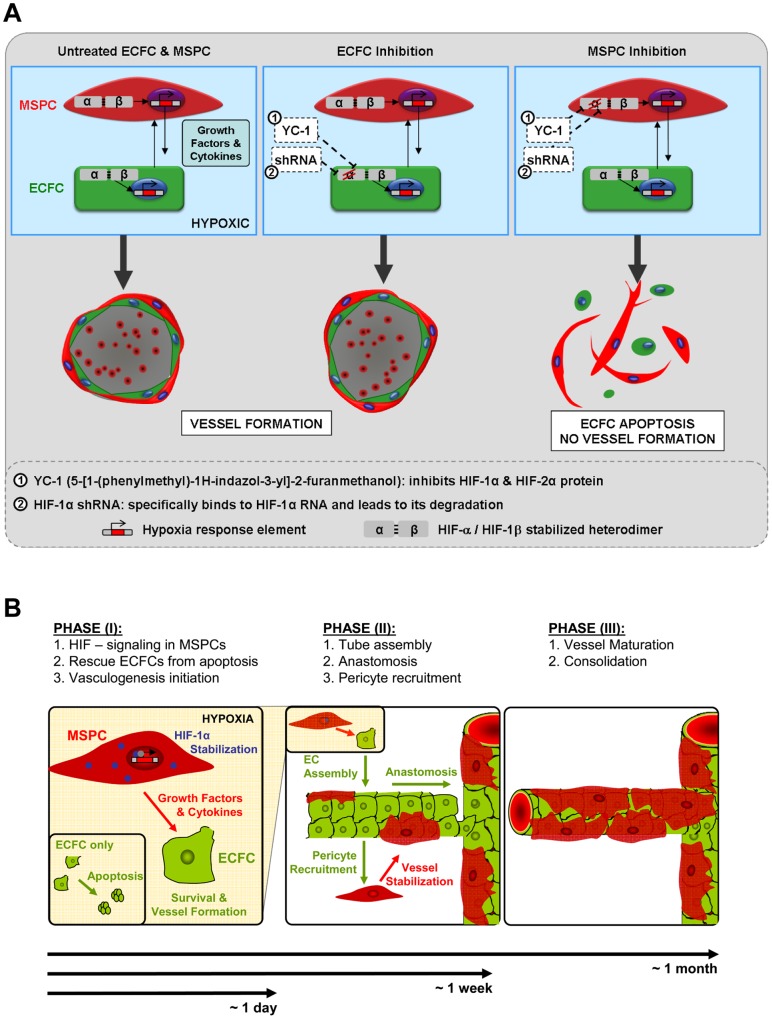
MSPCs are responsible for oxygen sensing and induction of neo-vasculogenesis.(A) The experimental strategy to delineate the hypoxia response used pre-treatment of either ECFCs or MSPCs before transplantation with YC-1 (inhibiting both HIF-1α as well as HIF-2α) or specific knockdown of HIF-1α RNA (by sh-RNA;). The surprising outcome of vessel formation despite the inhibition of ECFC hypoxia response and collapse of neo-vasculogenesis after MSPC inhibition is graphically illustrated. (B) Based on our current insight a model is proposed describing three temporarily distinct phases of adult vasculogenesis.